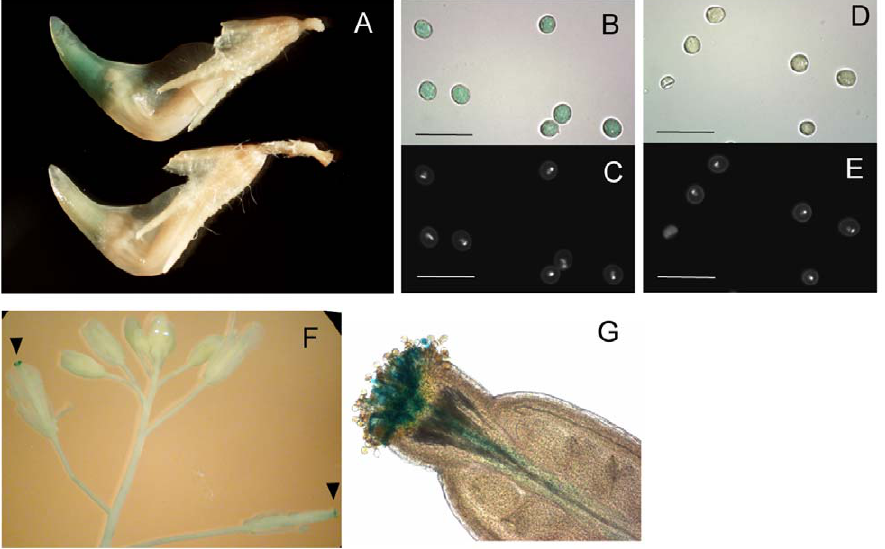
Figure 3. Promoter activity of the LORE1 a LTR. Histochemical GUS assay of transgenic plants containing a LORE1a LTR::GUS fusion. (A) GUS staining was observed at the tip of keel containing released pollen grains in a transgenic L. japonicus plant (upper), while no GUS activity was detected in the control Gifu (lower). (B,D) Close up of pollen grains after GUS staining of transgenic (B) and control Gifu (D) samples. Scale bars correspond to 50 m m. (C,E) Hoechst 33258 staining of the pollen grains shown in (B,D), respectively. (F) A transgenic Arabidopsis inflorescence incubated with GUS substrate for 12 h. Blue staining (GUS positive) was observed only at the pollinated pistils, indicated with arrowheads. GUS activity was not detected in other tissues. (G) Magnified image of a GUS-positive stigma. GUS activity was observed in pollen tubes penetrating the stigma and in hydrated pollen on the stigma.